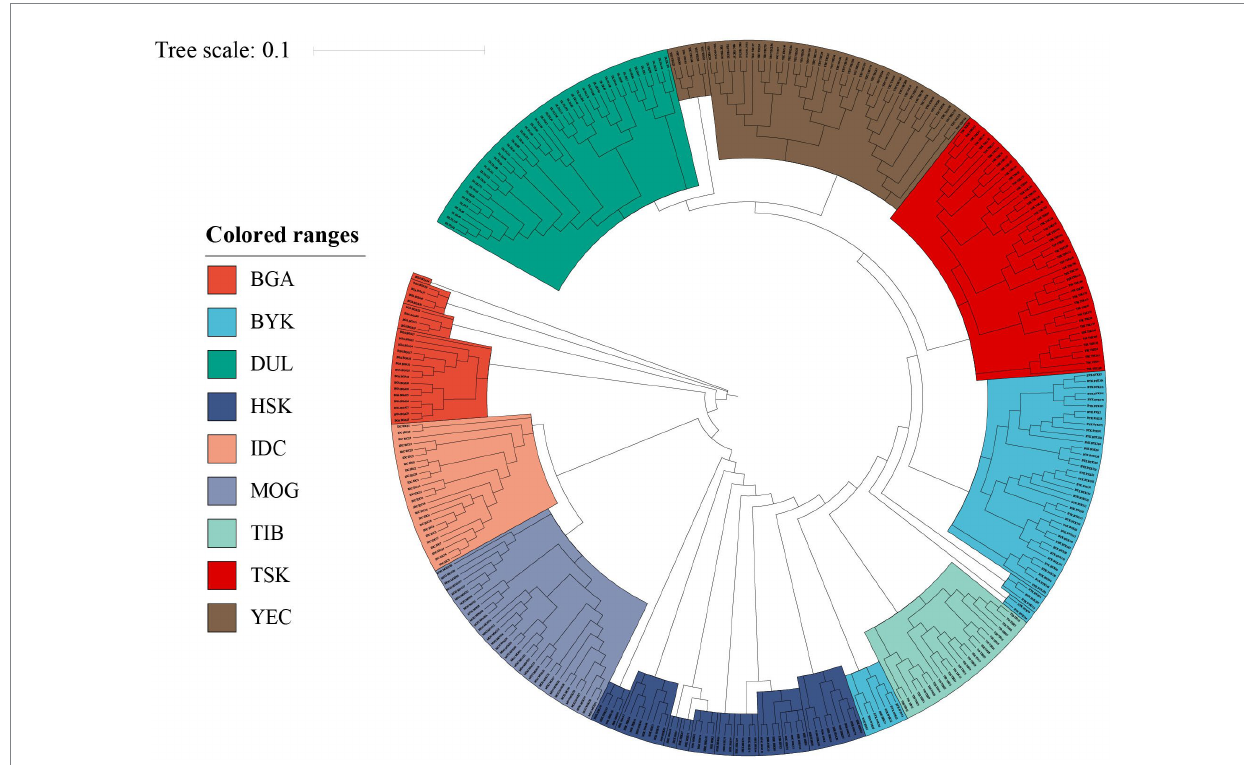
FIGURE 3 The result of Neighbor-Joining tree of nine sheep breeds. The indigenous sheep breeds in Xinjiang can be distinguished from those in other countries, and the relationships of YEC and DUL are closest.